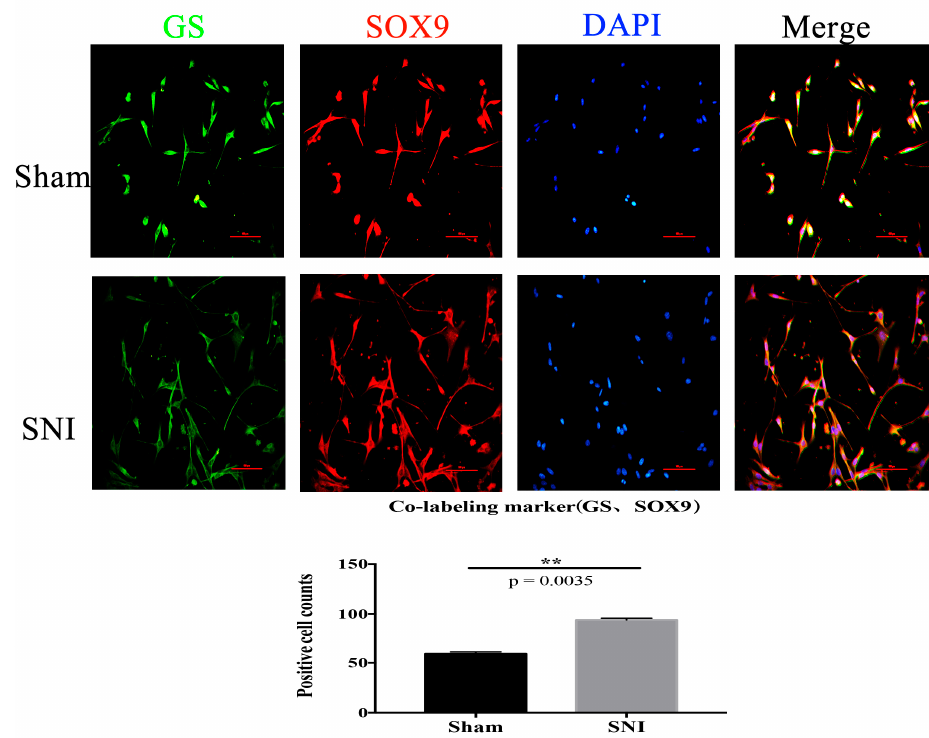
Figure 6. The co-labeling results of GS and Sox9 (Scale bar: 100 μ m, 200×) (** p = 0.0035).